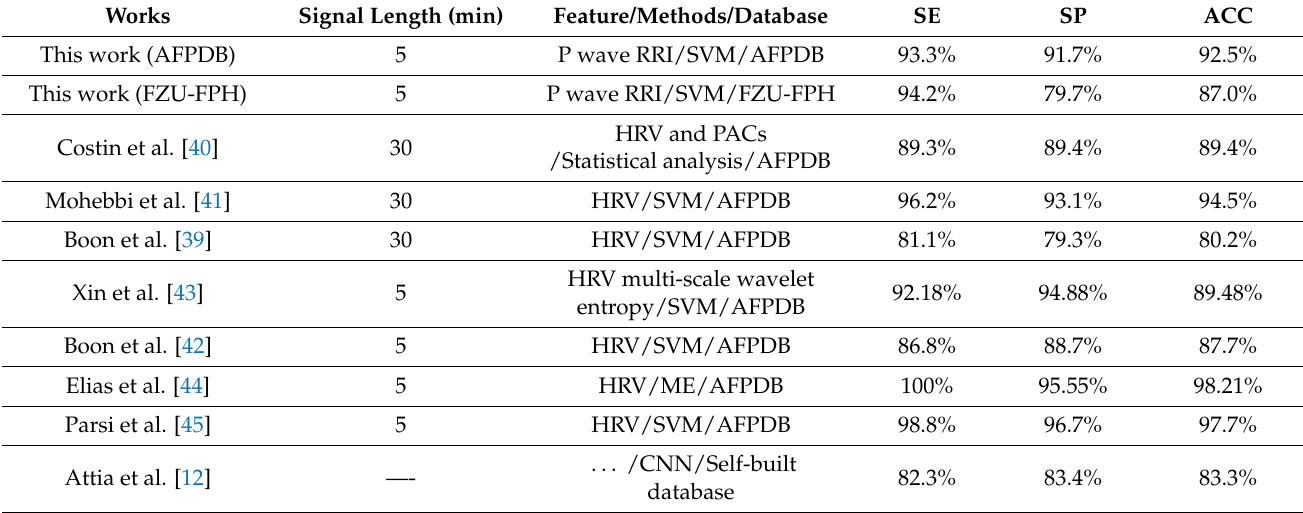
Table 12. Performance comparison of predictive models for paroxysmal atrial